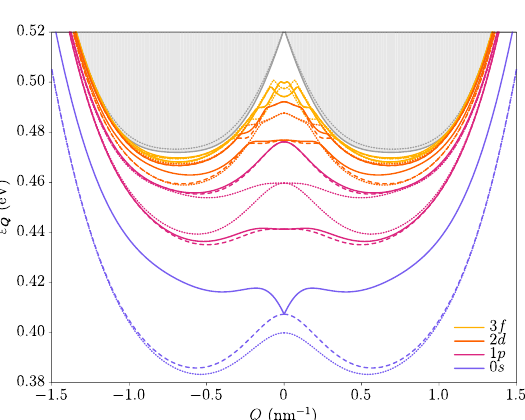
Figure 4. Excitonic dispersion relation for the Rytova–Keldysh potential. Shown are the exciton eigenstates 2 0 2 Q Q Q (dotted lines), (solid lines), and (dashed lines), with Q the total exciton momentum. | ; | ; | ; + � ± � − � 0 as indicated in the legend. The 1 s state (not shown) Different colors correspond to different values of m at Q = Q , 2 has higher energy than the 1 p , 2 d and 3 f states. The excitons with opposite angular momenta are split | ± � in energy, with the higher state having angular momentum m > 0 and the lower state m < 0 . The gray region at the top represents the electron-hole continuum, delimited by a solid gray line resulting from analytically minimizing the energy gap with respect to the relative electron-hole momentum in the absence of interactions. The gray dotted line represents the continuum threshold as calculated numerically including only angular 3 and tends to the solid line upon inclusion of higher values of | m |. m momenta | | ≤